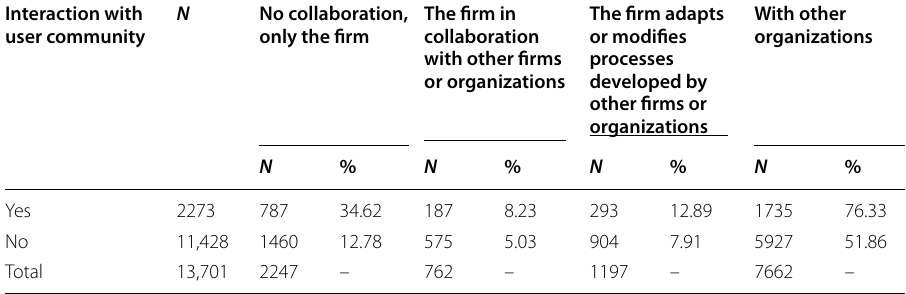
Table 5 Collaboration with external partners for innovation development Interaction with user